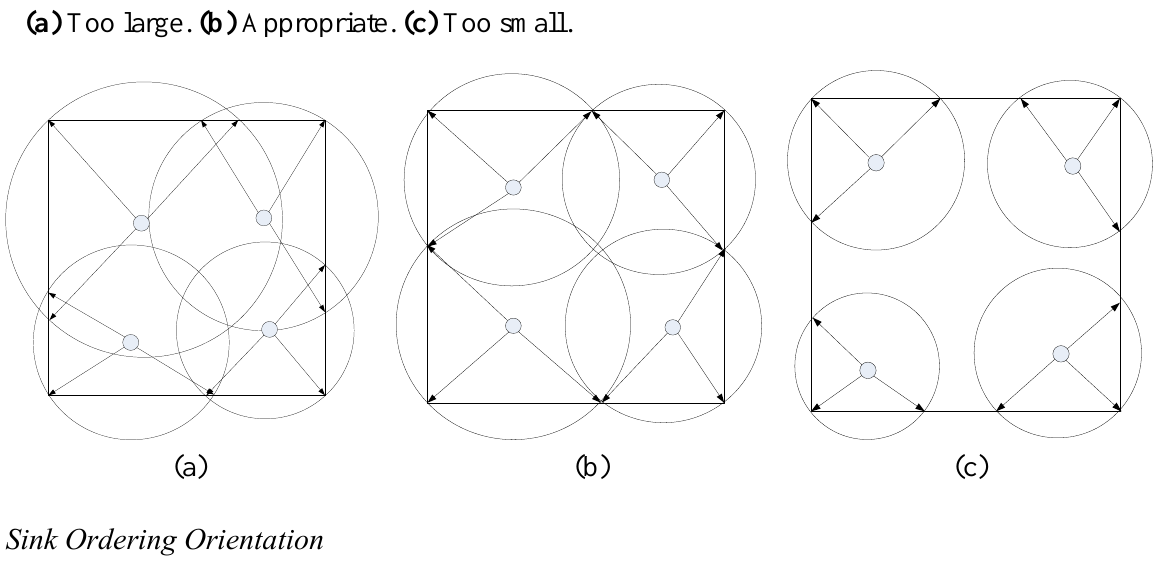
Figure 5. Illustration of radio radius calculation when deploying 4 sink nodes in work